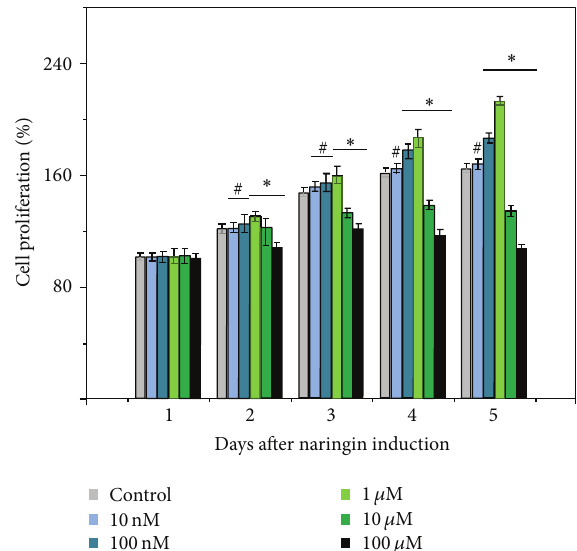
Figure 5: Proliferation of hPDLSCs stimulated by naringin. Data were shown as the mean ± SD ( 𝑛 = 6 ). ∗ is compared with control group, 𝑃 < 0.05 . # indicates no significant difference. There is no significant difference between the blank control and the treatment group at the concentration of 10nM naringin. At day 4, with an over 20% increase in proliferation rate, the difference between the blank control and the treatment group was significant ( 𝑃 < 0.05 ) when naringin concentration was increased to 100nM. The treatment group consistently exhibited a significant increase in proliferation rate over the blank control ( 𝑃 < 0.05 ) at the concentration of 1 𝜇 M naringin. However, when we further increased naringin concentration up to 100 𝜇 M, we found a detrimental effect.